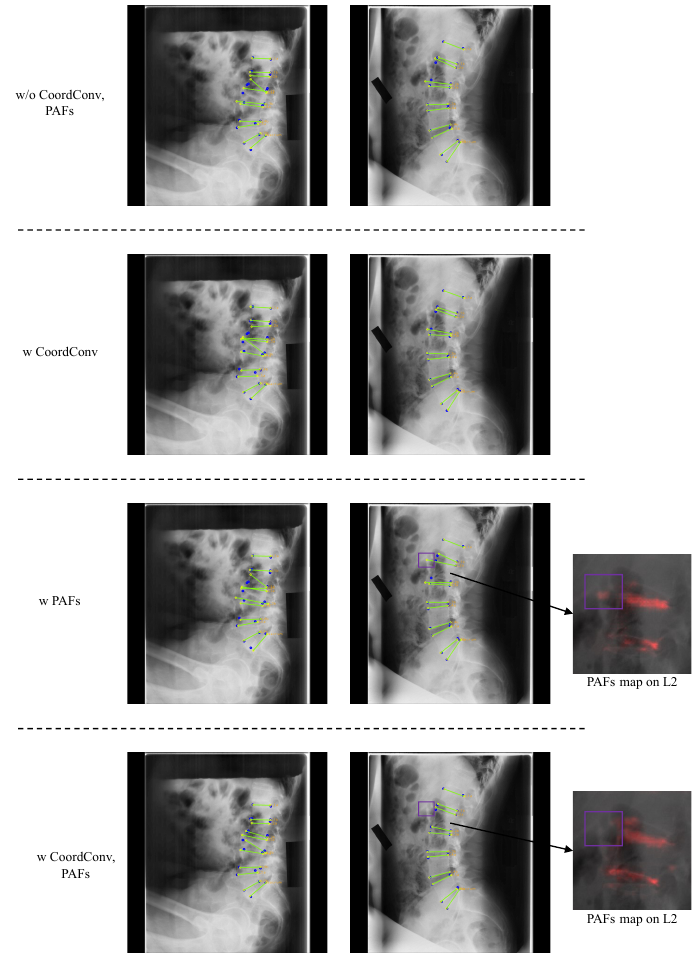
Figure 16. Results of ablation study with CoordConv and PAFs. The blue circles represent the ground truth, while yellow circles with labels represent predicted results, and the green lines represent the line connecting the predicted landmarks of an